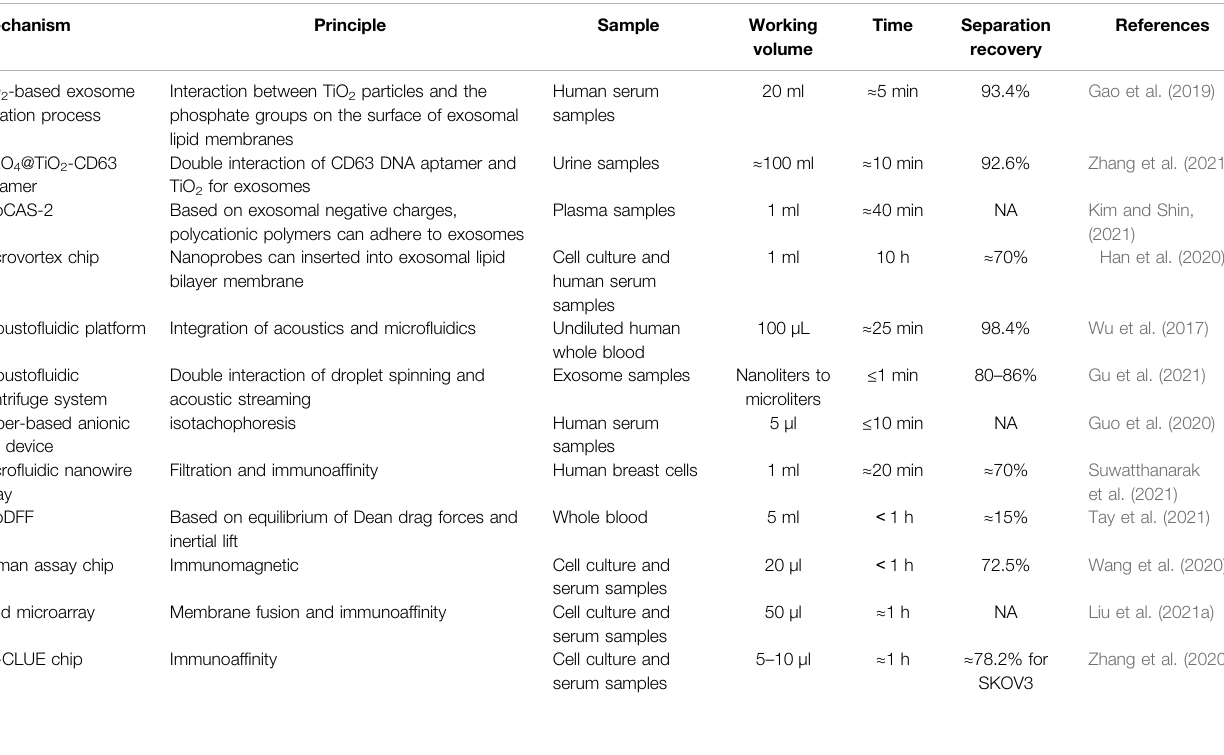
TABLE 2 | Comparison of micro fl uidics and other emerging approaches for exosome